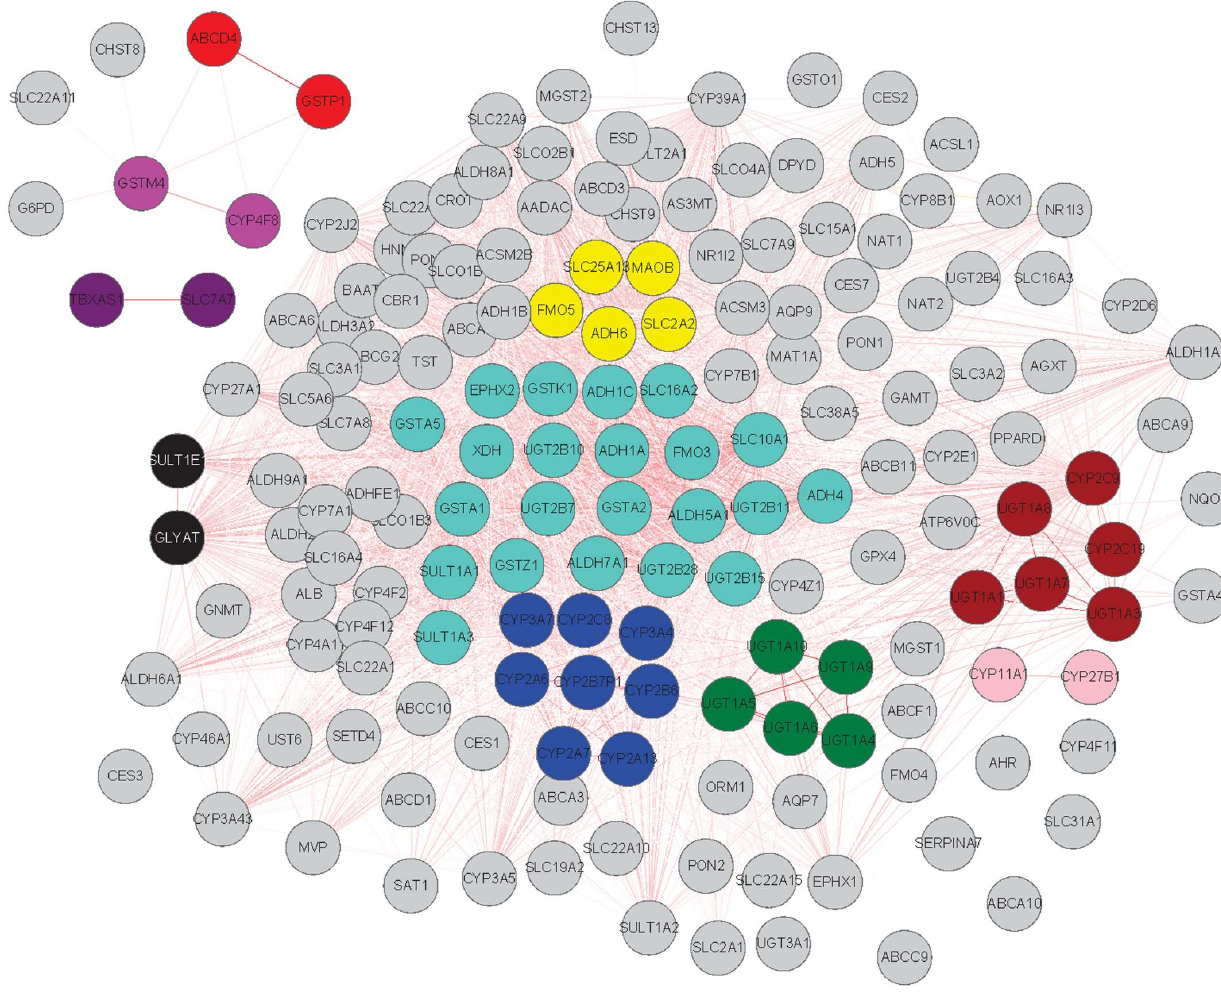
Figure 3. A topological overlap matrix (TOM) of all 374 DMET genes. Both the rows and the columns are sorted by hierarchical clustering. The colors specify the strength of the pair-wise topological connections (yellow: not significantly connected; red: highly connected). Genes that are highly connected within a cluster are defined as a module. Each module was assigned a unique color identifier (turquoise and blue), with the remaining genes colored gray.